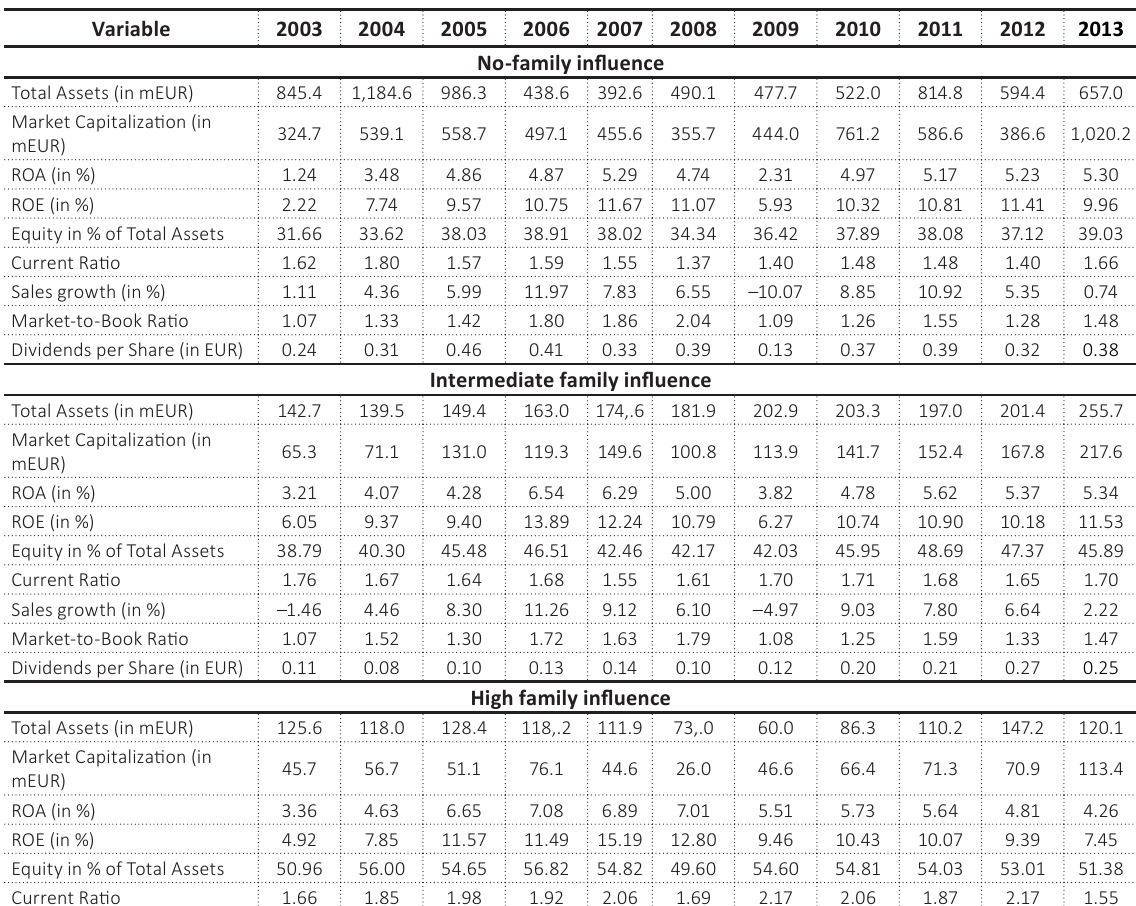
Table B1. Comparison of operating performance per year